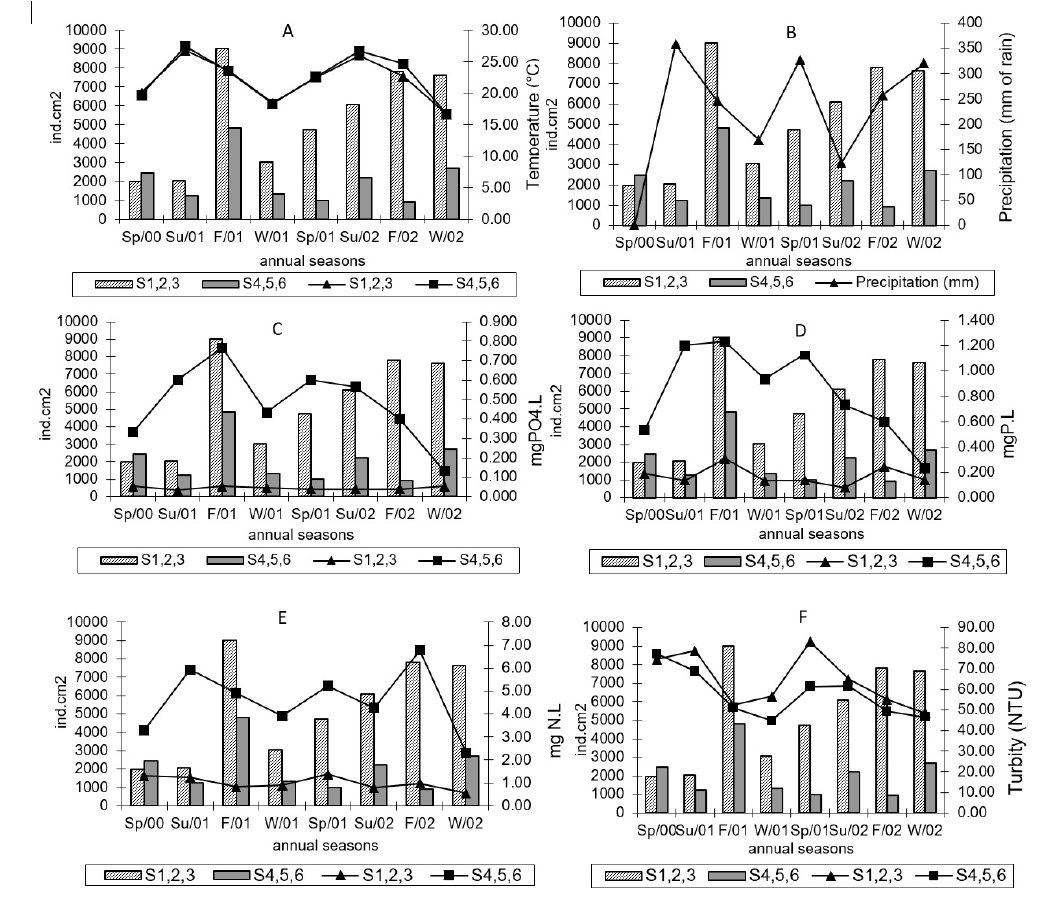
Figure 5. Seasonal variation of the mean values of total diatom density (ind cm 2 ) and of the environmental variables (Water temperature (°C), precipitation (mm), orthophosphate (mg L -1 ), total phosphorus (mg L -1 ), total nitrogen (mgN L -1 ) and turbidity (NTU), during different seasons, sampled in the period from September 2000 to August 2002 (Sp = spring; Su = summer; F = fall; W =